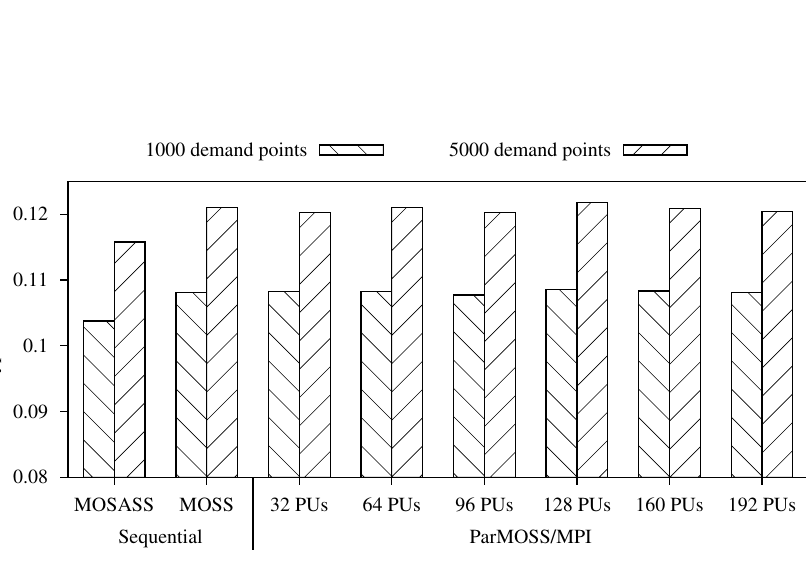
Figure 8. Average values of hyper-volume, obtained by sequential MOSASS and MOSS and parallel distributed-memory MOSS (ParMOSS/MPI) using different numbers of processing